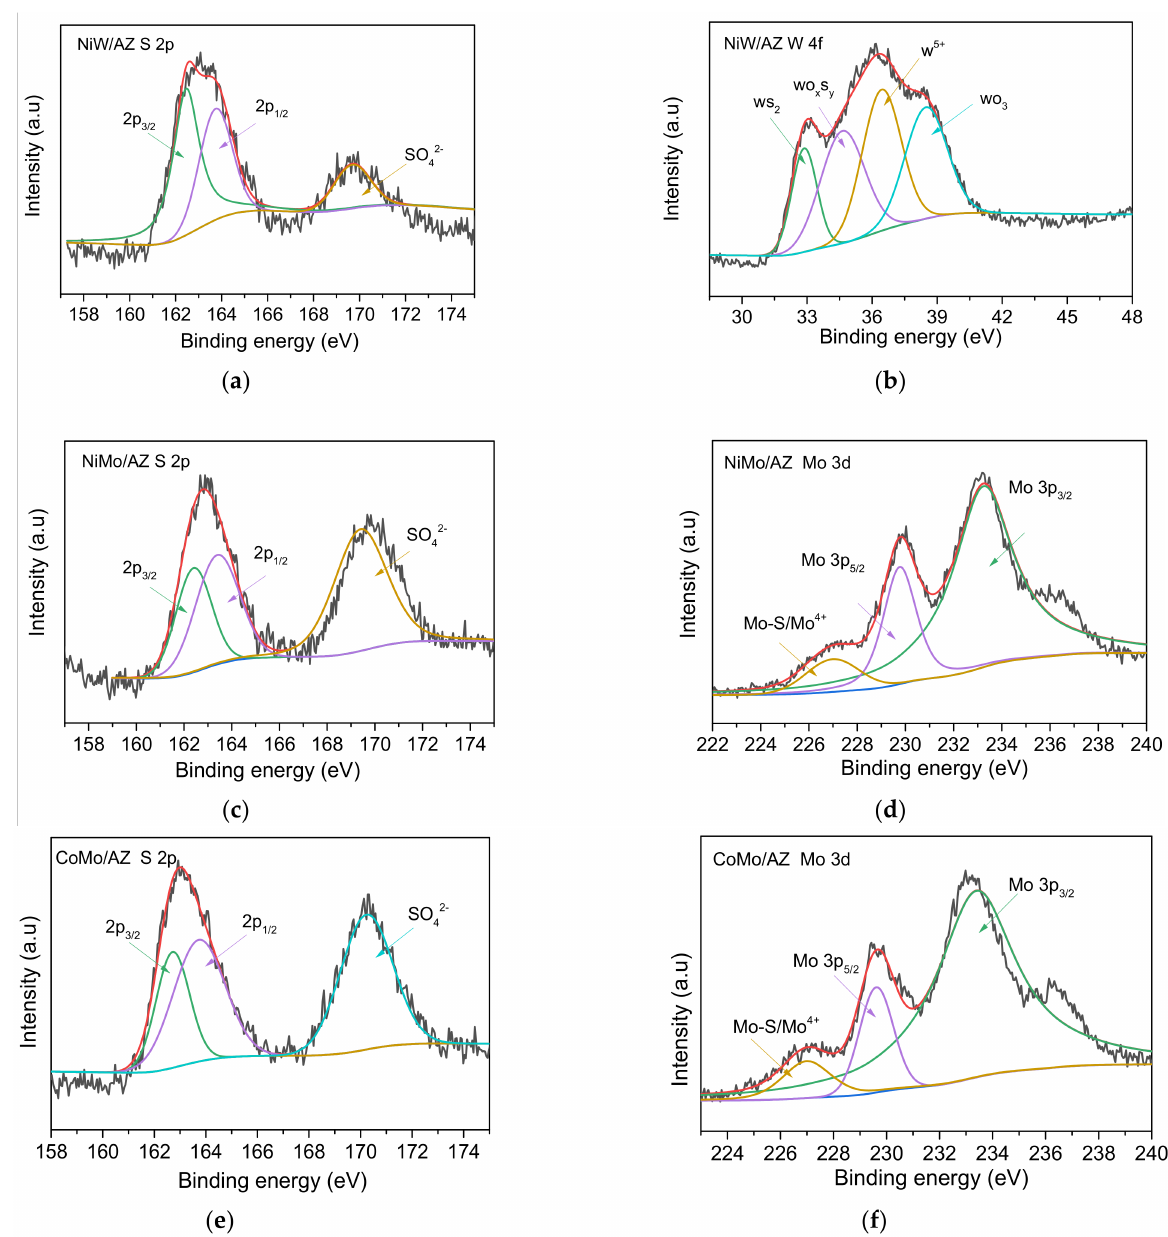
Figure 5. XPS spectra of the sulfided catalysts. ( a ) NiW/AZ S 2p; ( b ) NiW/AZ W 4f; ( c ) NiMo/AZ S 2p; ( d ) NiMo/AZ Mo 3d; ( e ) CoMo/AZ S 2p; ( f ) CoMo/AZ Mo